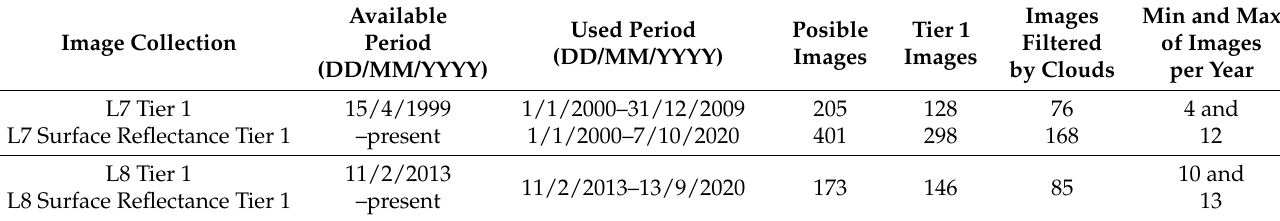
Table 3. Satellite data. Available and used period. From the latter: possible and resulting images after Tier 1 and cloud cover <30% filters. Image Collection